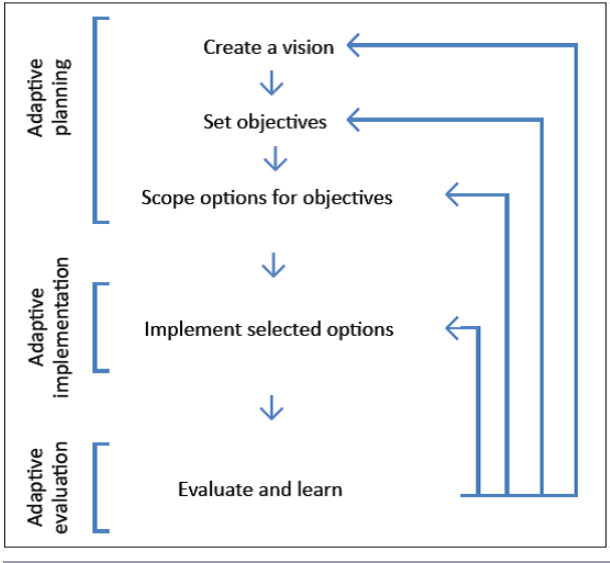
Fig. 2 . Schematic summary of the steps in the strategic adaptive management process. From Roux and Foxcroft